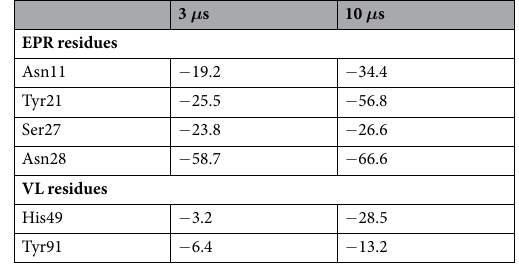
Table 1. Main interaction energies with Asp102 in the green trajectory (kJ/mol). The interaction energies were calculated for 2.9 to 3.0 μ s and for 9.9 to 10 μ s